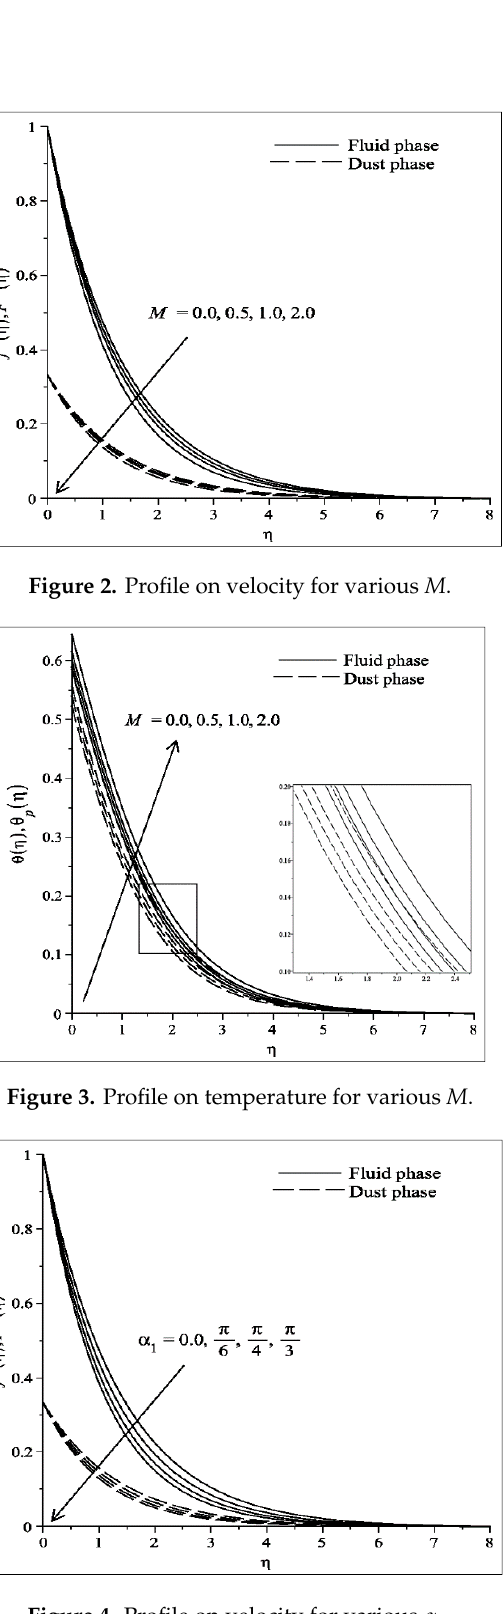
Figure 4. Profile on velocity for various α 1 .